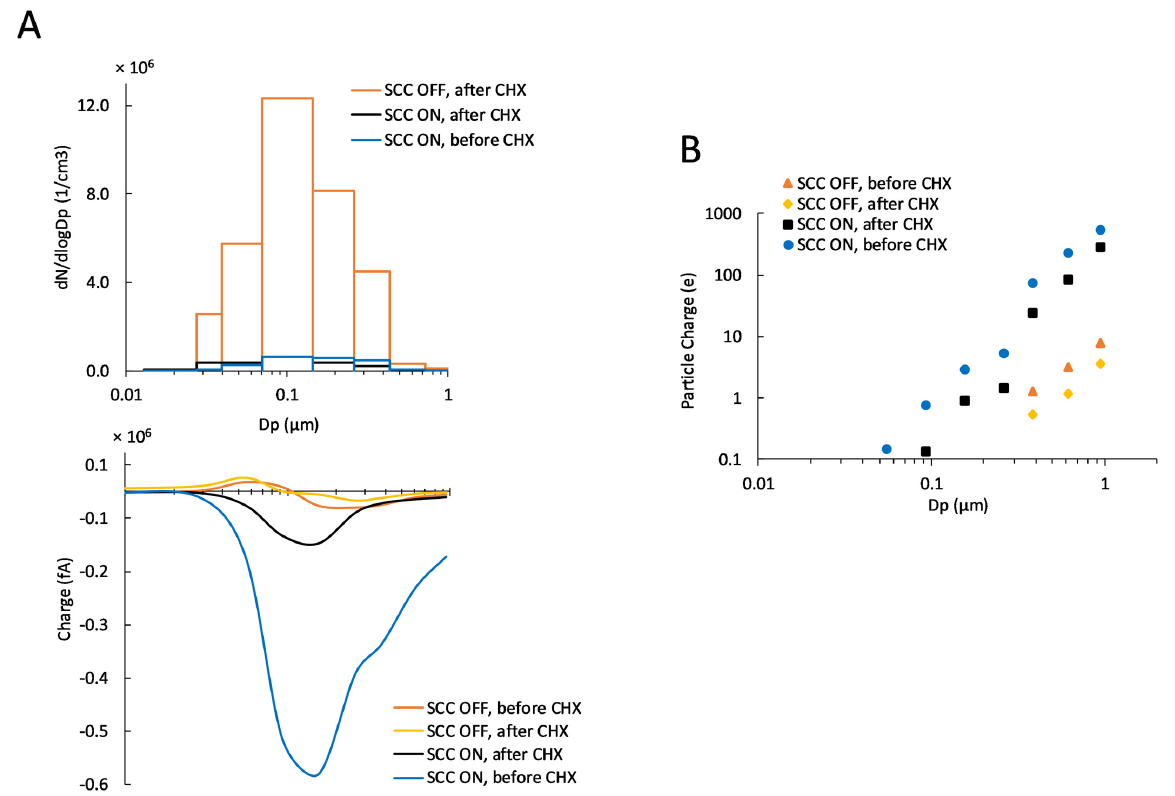
Figure 8. ( A ) Comparison of particle number and charge size distributions before and after the condensing heat exchanger (CHX) with particle charging on and off and ( B ) single particle charge distribution.